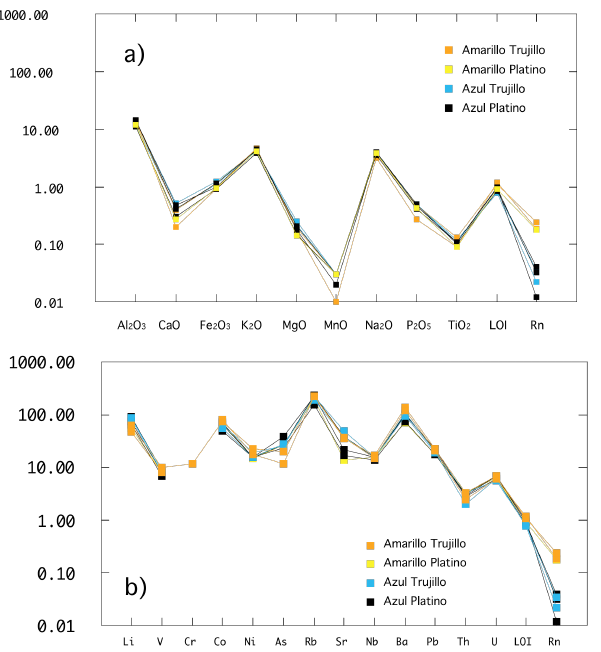
Fig. 3. The largest geochemical difference observed among samples is reflected by the LOI values and Rn exhalation. Major (a) and trace (b) elements have very similar values. Major elements and LOI are expressed in %; trace elements are expressed in ppm.